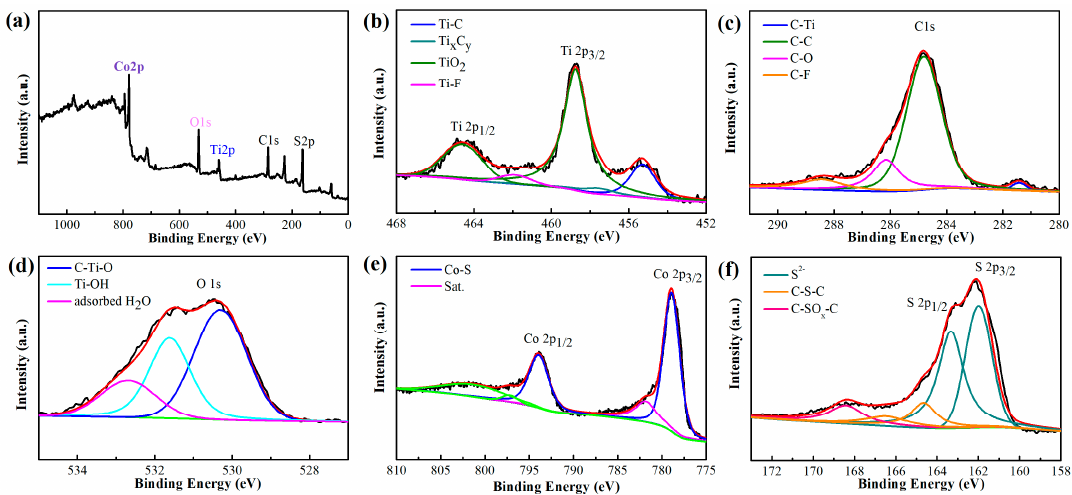
Figure 3. X-ray photoelectron spectroscopy (XPS) survey spectra of CoS@Ti 3 C 2 T x : ( a ) survey spectrum, ( b ) Ti 2p, ( c ) C 1s, ( d ) O 1s, ( e ) Co 2p, and ( f ) S 2p.